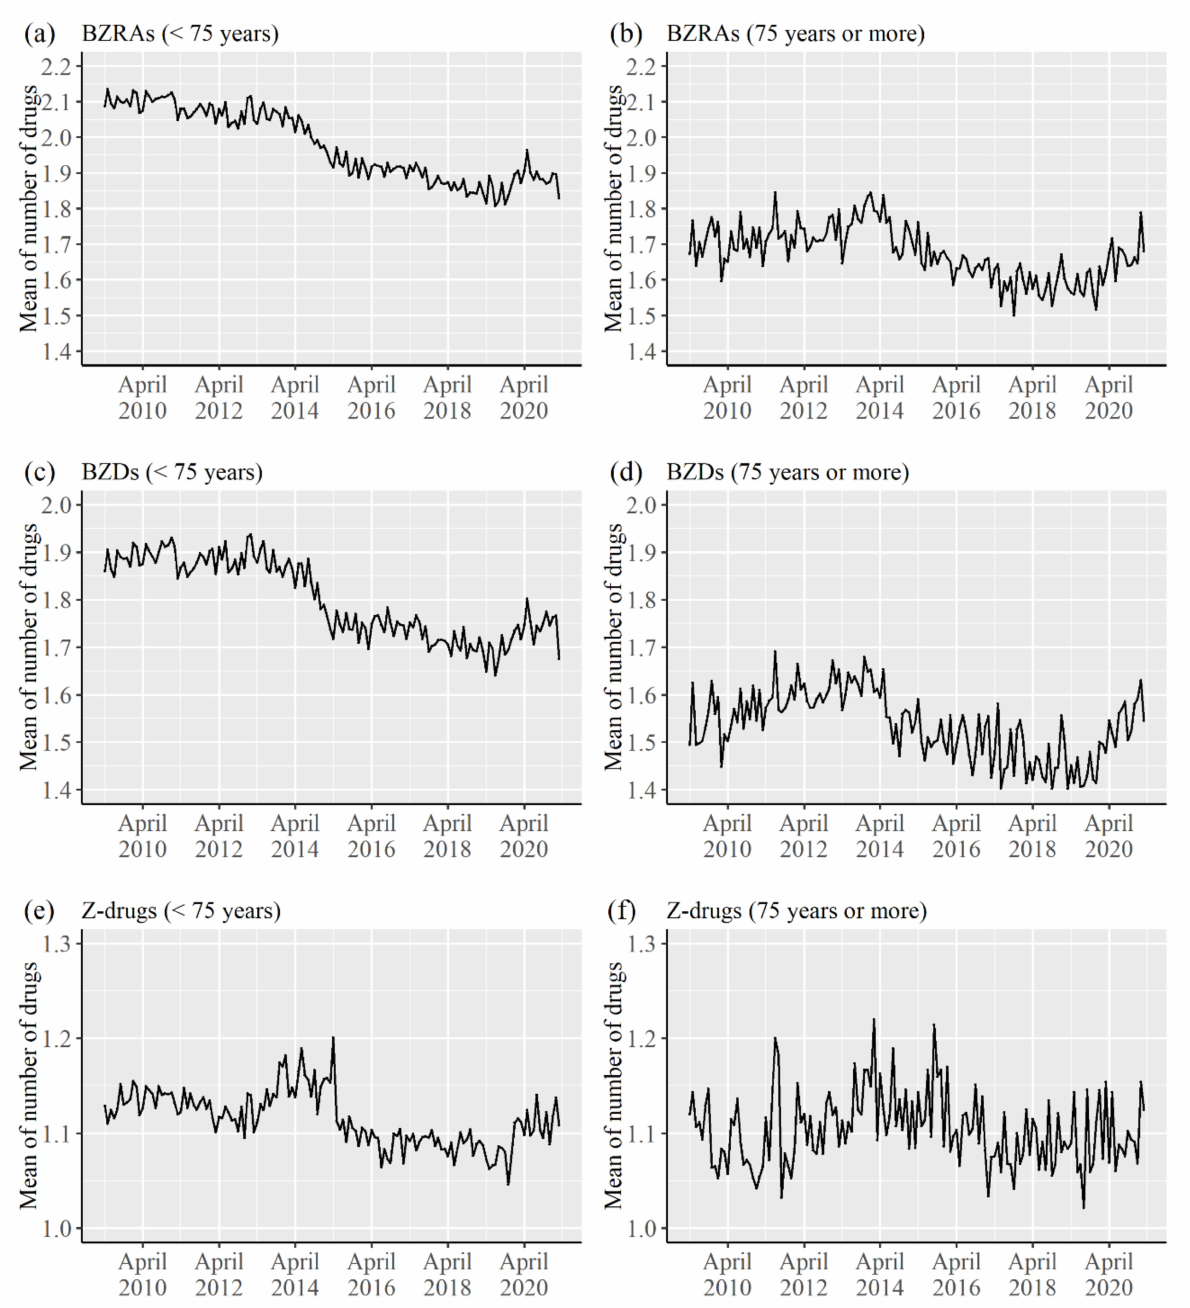
Figure 2. Trends of the mean of number of the types of drugs prescribed to a patient in a month as per the age group and type of drugs. ( a ) Mean for BZRAs in patients aged <75 years. ( b ) Mean for BZRAs among patients aged ≥ 75 years. ( c ) Mean for BZDs among patients aged <75 years. ( d ) Mean for BZDs among patients aged ≥ 75 years. ( e ) Mean for Z-drugs among patients aged <75 years. ( f ) Mean for BZDs among patients aged ≥ 75